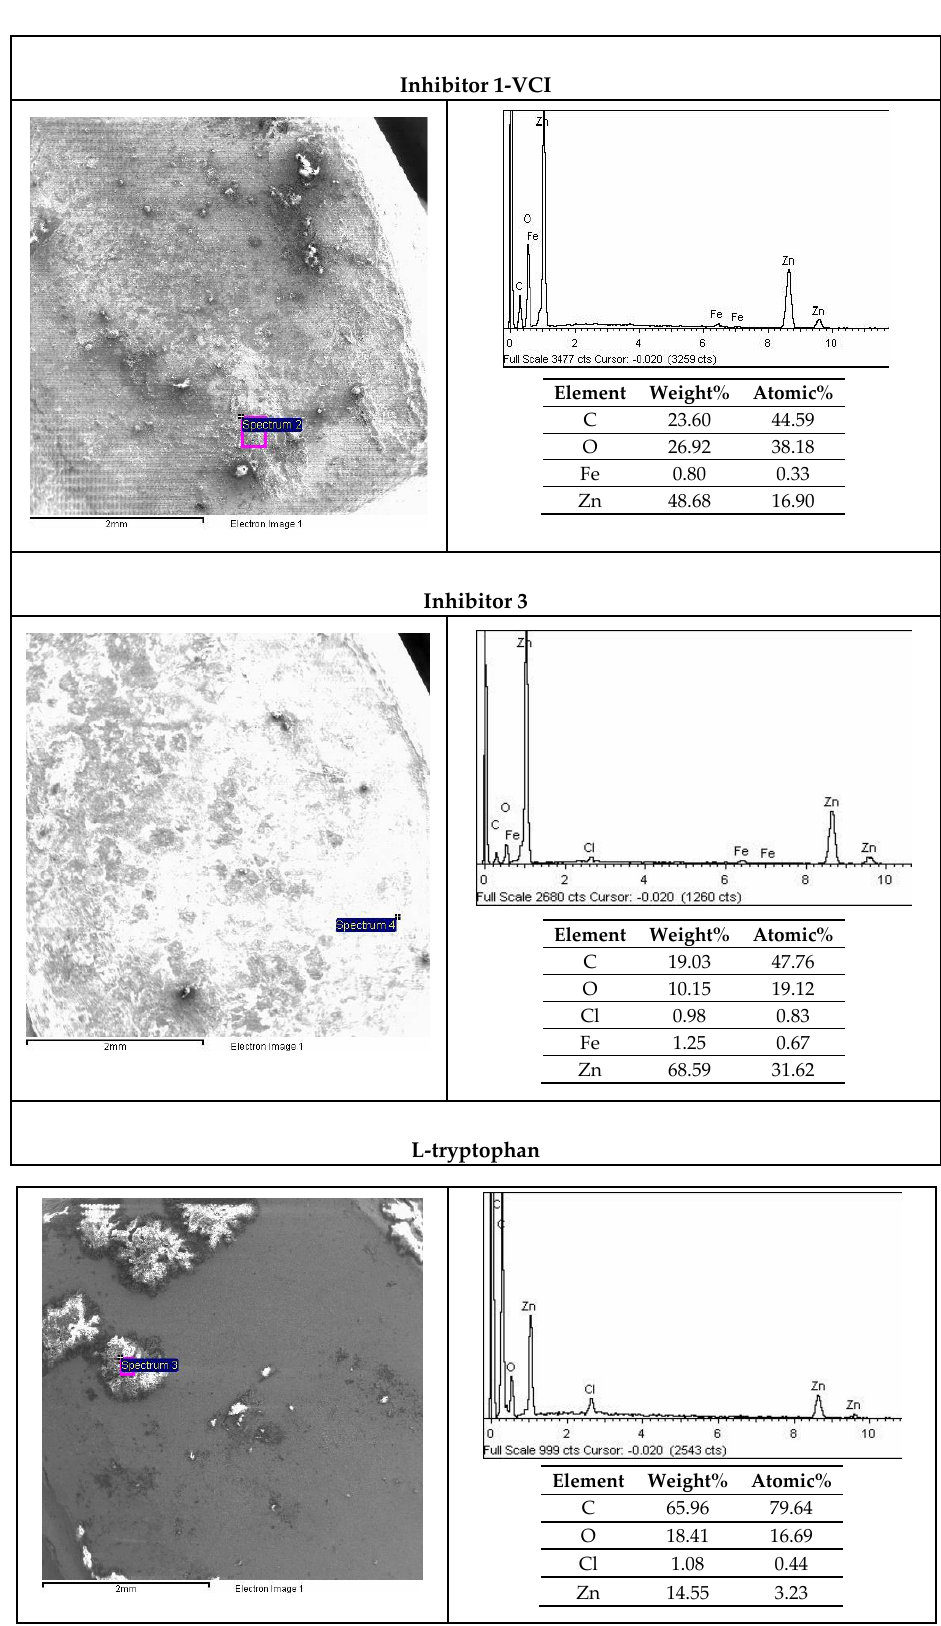
Figure 11. SEM and EDX view of inhibitor layer after 24 h in fresh water.